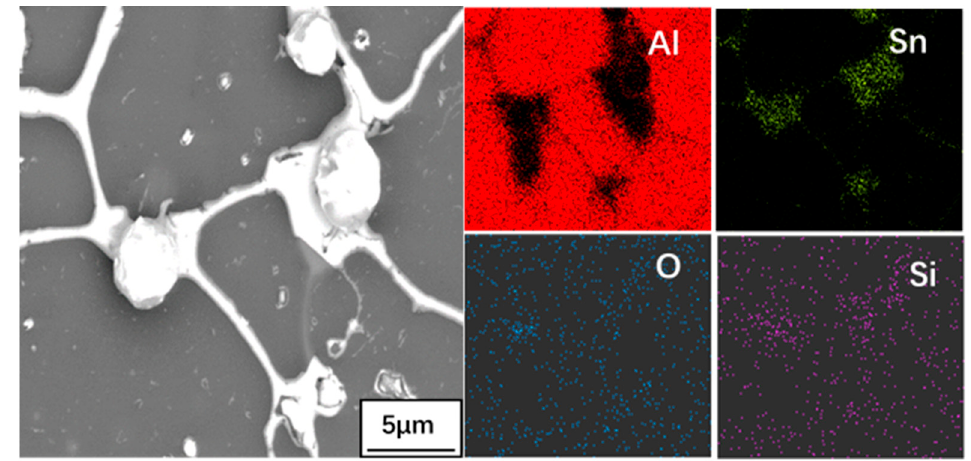
Figure 4. Surface SEM images and EDS map of Al-Sn alloy oxidized for 12 h at 300 °C.